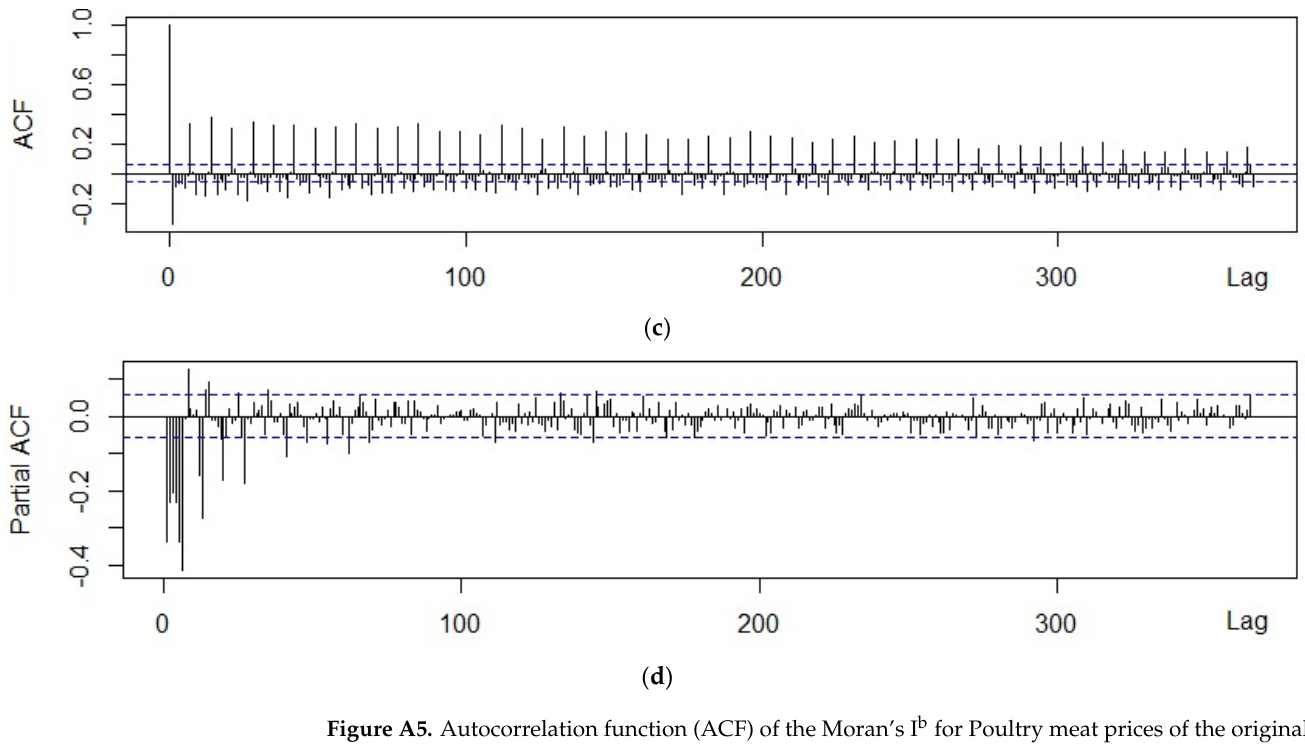
Figure A5. Autocorrelation function (ACF) of the Moran’s I b for Poultry meat prices of the original time series ( a ) and of the first differences ( c ); Partial autocorrelation function (PACF) of the Moran’s I b for Poultry meat prices of the original time series ( b ) and of the first differences ( d ). The Moran’s I b indexes are calculated based on binary contiguity matrices.